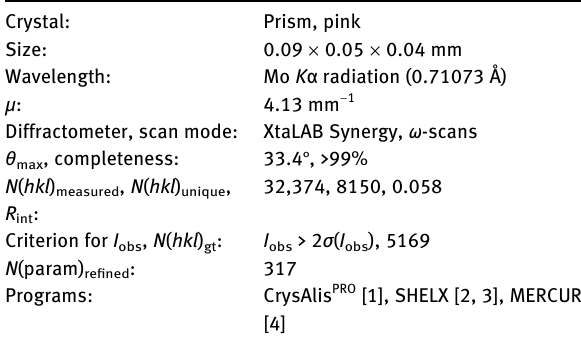
Table  : Data collection and